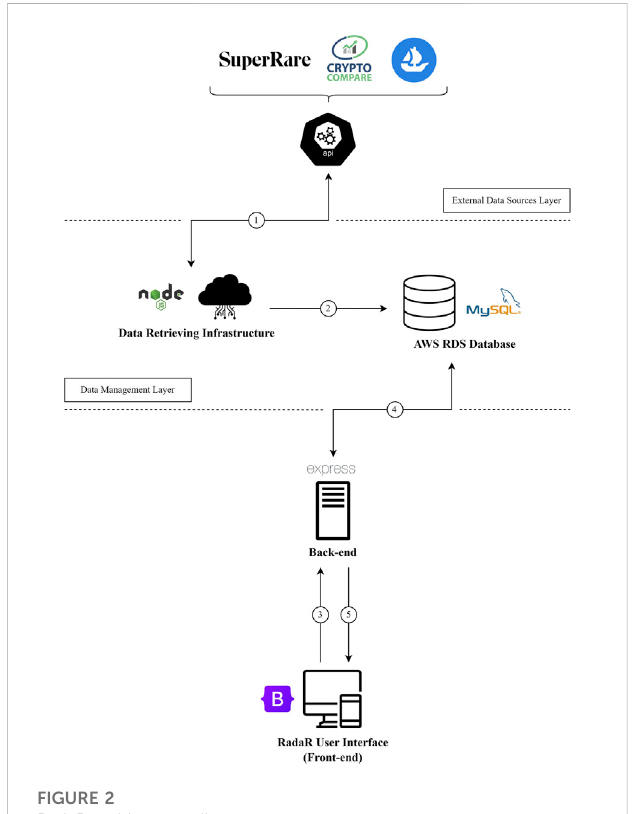
FIGURE 2 RadaR architecture